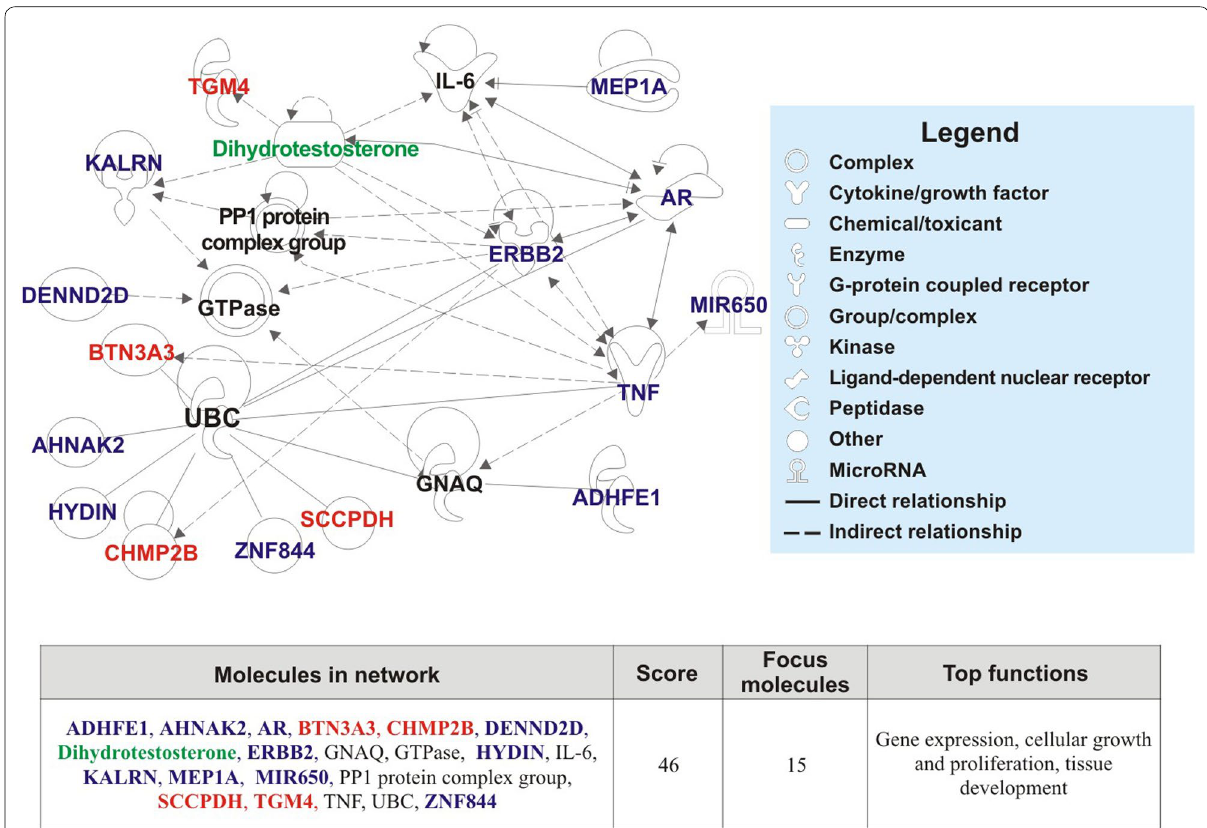
Fig. 3 Network of genes and molecules inferred from Ingenuity ® Pathway Analysis (IPA). The 13 genes exhibiting truncating variants were combined with the erb-b2 receptor tyrosine kinase 2 ( ERBB2 ) gene harboring the rs1058808 single nucleotide polymorphism (SNP), which was predicted to be deleterious by the sorting intolerant from tolerant (SIFT) and polymorphism phenotyping version 2 (PolyPhen-2) tools, the micro- RNA-650 ( MIR650 ) gene (a colorectal cancer-related gene), and the androgen receptor ( AR ) gene harboring the pathogenic rs9332969 SNP to test the putative enrichment of the canonical pathways, disease and biological functions, and molecular networks. When the short list of altered genes was examined using the IPA software, a single pathway (top functions: gene expression, cellular growth and proliferation, tissue development) with a high score (46, P < 0.001) was identified. Genes highlighted in blue were identified to be altered in III.2 (proband) and III.3 (cousin). Genes high- lighted in red were found to be altered only in subject III.2. The dihydrotestosterone molecule is highlighted in